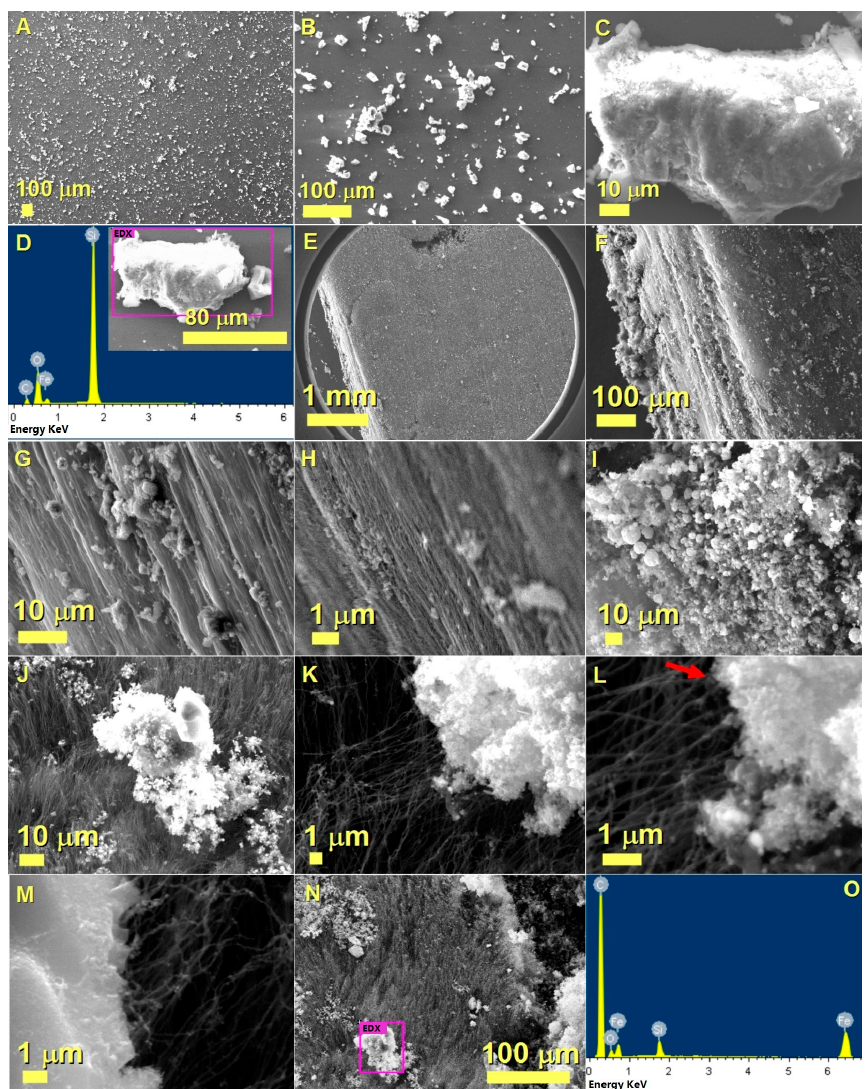
Figure 1. Scanning electron microscopy (SEM) images showing the Si/SiO 2 substrate after deposition of the SBA-16 supported catalyst species from a top view in ( A , B ) and with a higher magnification in ( C ). In ( D ) the Energy Dispersive X-ray (EDX) spectrum obtained from the area shown in the inset is shown. The as grown buckypaper morphology and cross-section after chemical vapour deposition (CVD) are shown with an increasing level of detail from ( E – H ). In ( I – J ) the presence of the SBA-16 supported catalyst species is shown. In ( K – M ), SEM micrographs showing the presence of a direct connection between the grown carbon nanotubes (CNTs) and the SBA-16 supported catalyst are shown. In ( N – O ) a typical EDX analysis of the SBA-16 supported catalyst is